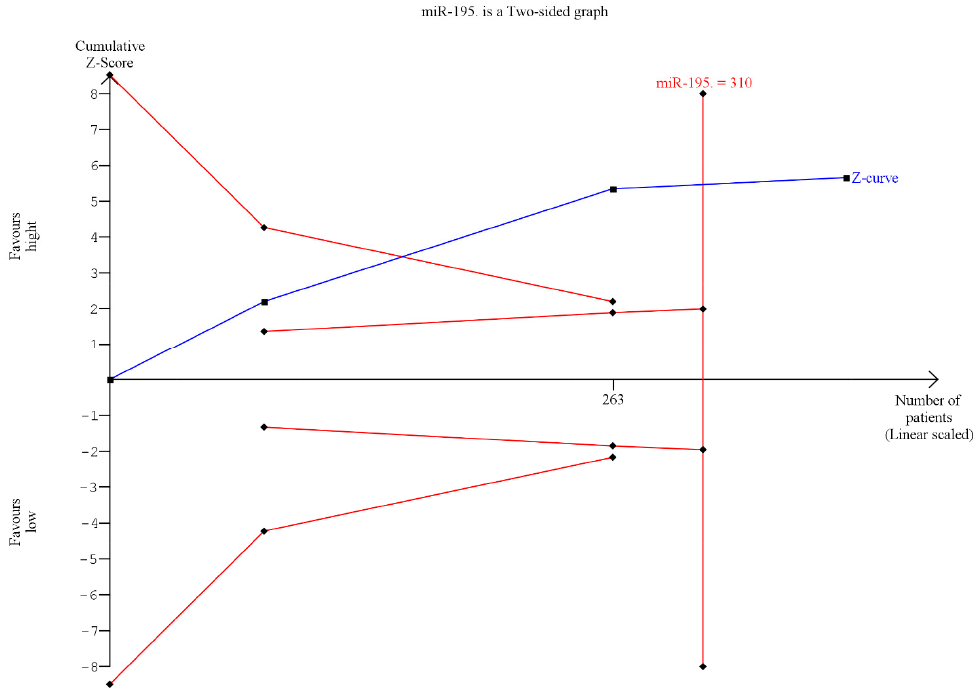
Figure 4. Trial sequential analysis (TSA) was performed to evaluate the potency of the result of the meta-analysis.